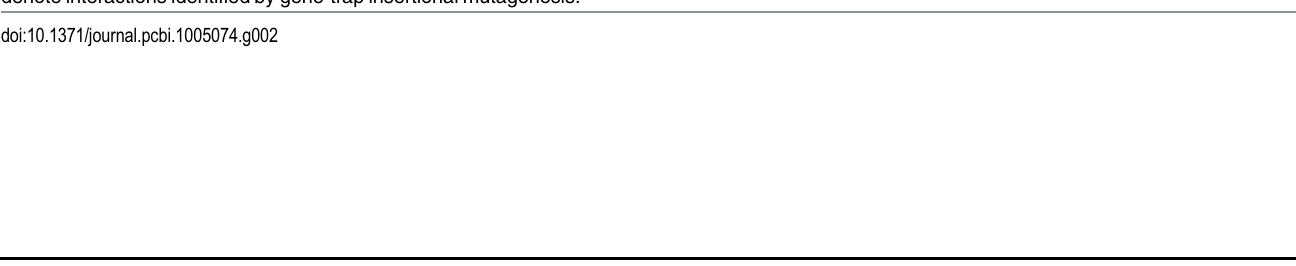
Fig 2. The newly identified virus-host interaction networks by gene-trap insertional mutagenesis. The nodes (squares) are viruses, host cell gene products (circles) are colored based on their subcellular locations collected from LocDB (https://www.rostlab.org/services/locDB/), and edges (lines) denote interactions identified by gene-trap insertional